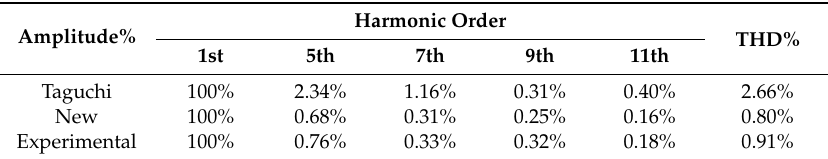
Table 11. Comparison of harmonic content.